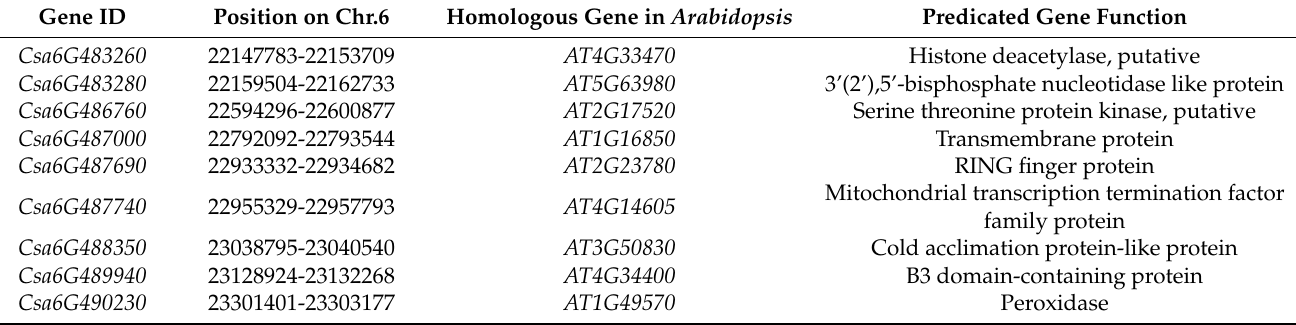
Table 3. Candidate genes responsible for cucumber salt tolerance with major quantitative trait loci (QTL) qST6.2 .